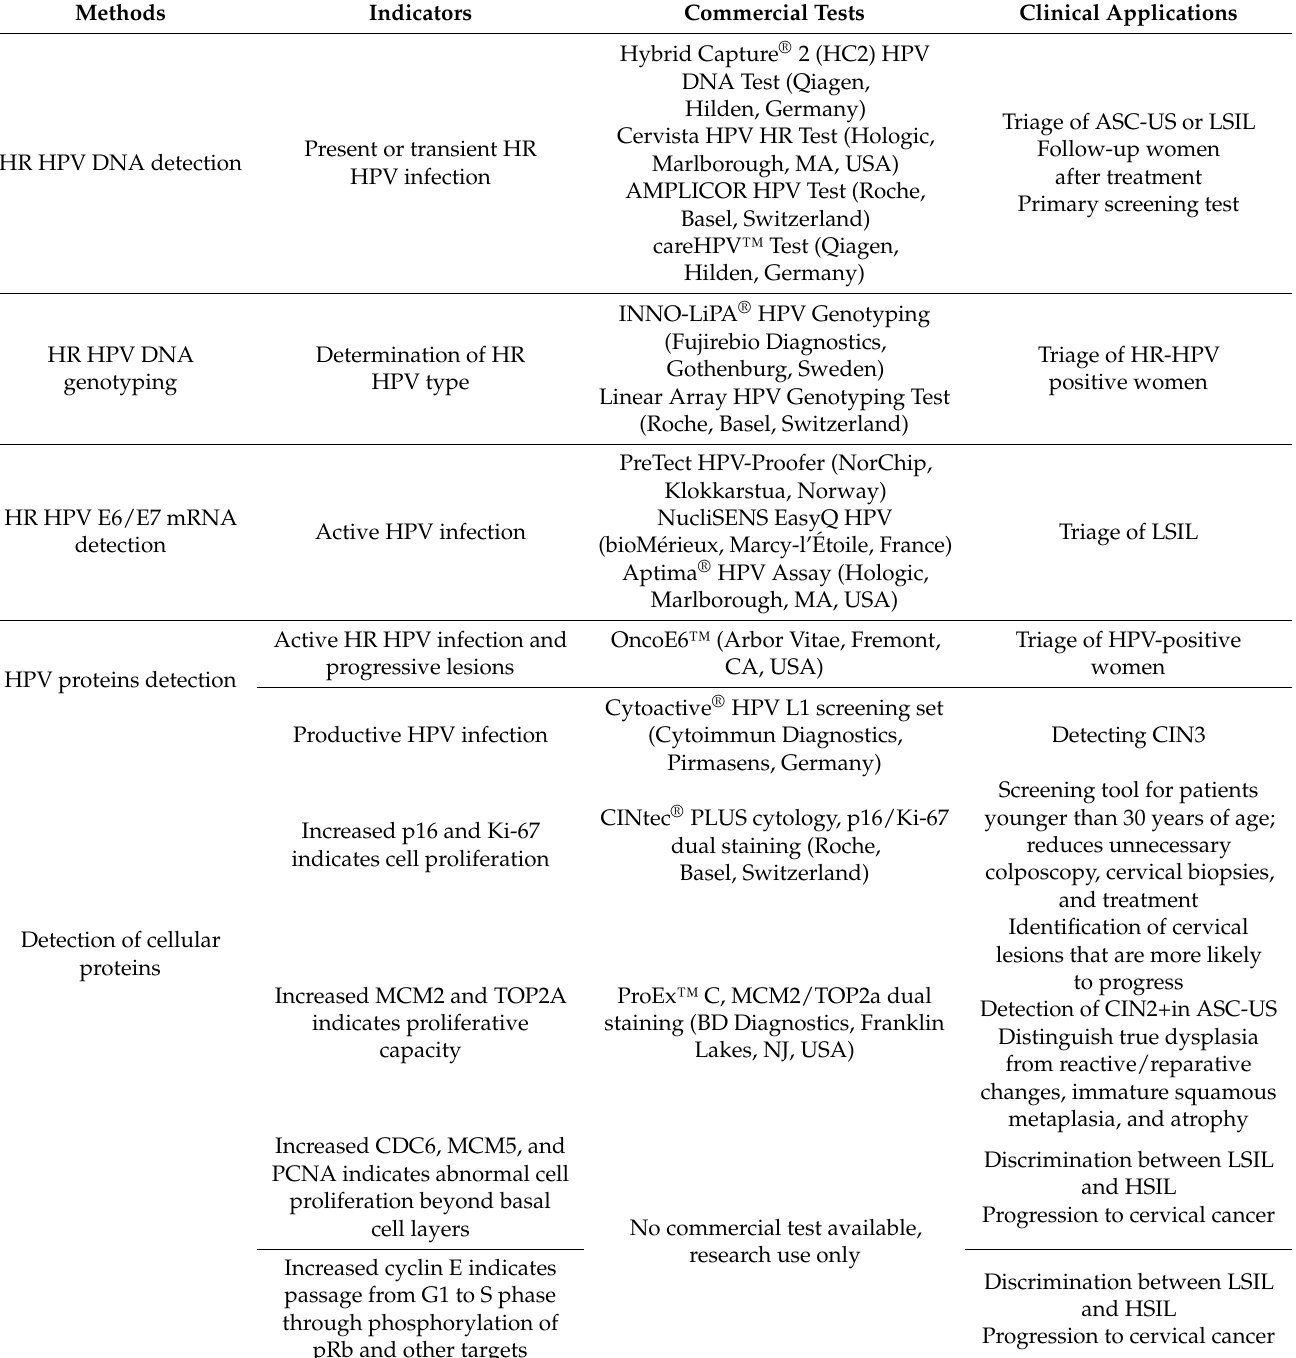
Table 2. HPV related biomarkers in clinical practice and